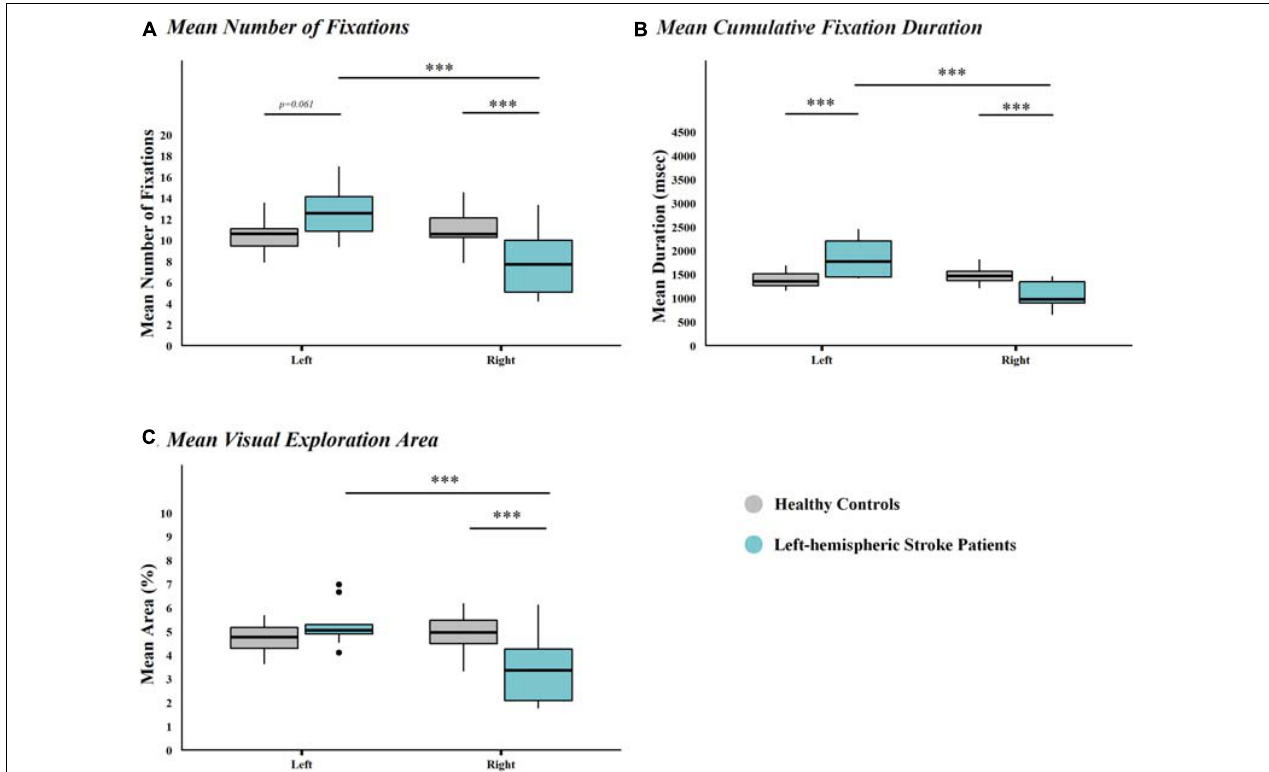
FIGURE 4 | Mean Number of Fixations, Mean Cumulative Fixation Duration, and Mean Visual Exploration Area, per Group and Screen half. Box-and-Whisker plots of (A) mean number of fixations, (B) mean cumulative fixation duration, and (C) mean visual exploration area, per Group and Screen half. Results of left-hemispheric stroke patients ( n = 10) are depicted in light blue, those of healthy controls ( n = 20) in grey. Significant post hoc differences, as evidence by Bonferroni-corrected t -test, between the different combinations of factor levels are depicted by asterisks ( ∗∗∗ p < 0.001). Median values per group are indicated by the horizontal black line in each box. Each box represents the lower (Q1) to the upper (Q3) quartiles, with whiskers extending to the minimum and maximum of 1.5 times the interquartile range. Outliers are indicated by black